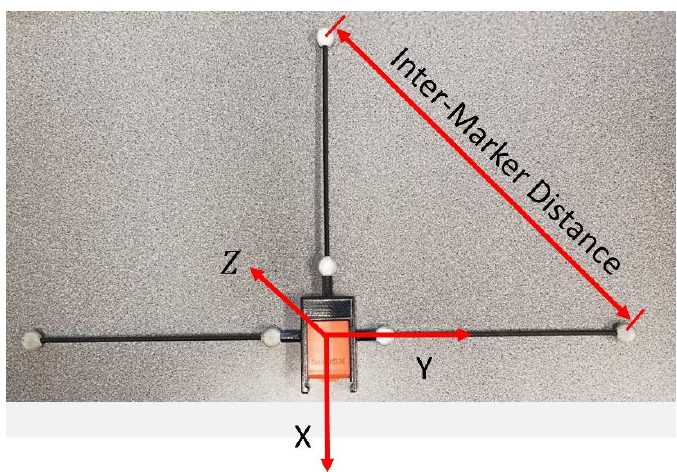
Figure 6. An inertial sensor inside a marker adapter. The coordinate system generated from the markers is denoted by the arrows and defines the IMU’s local coordinate system. Note that the offset vector determined by the accelerometer’s location within the IMU has not yet been applied to the origin of the coordinate system shown.